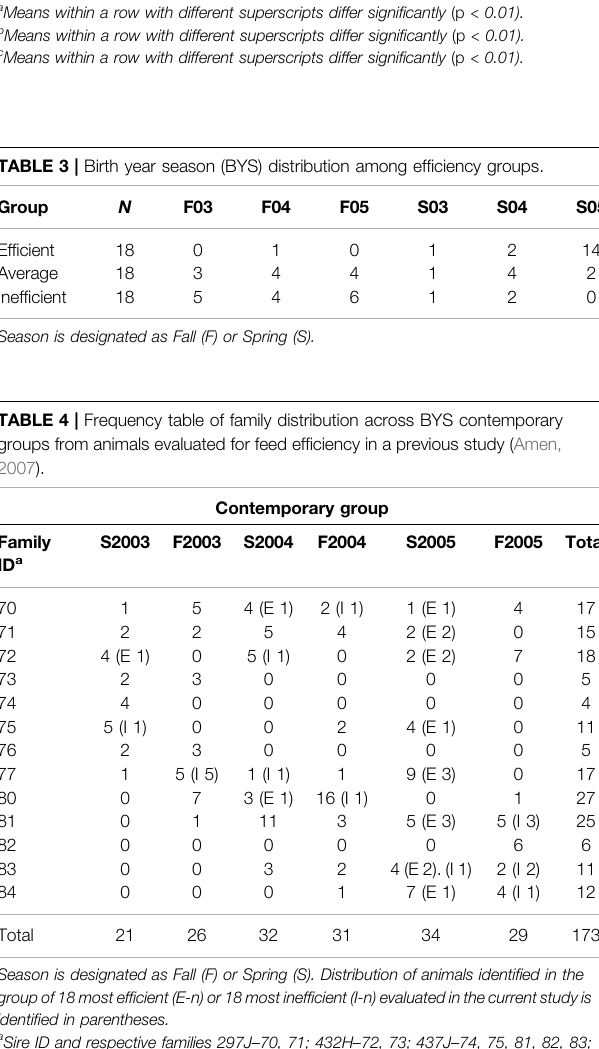
TABLE 1 | Ration formulation used for steers in study. Ingredient % Ground